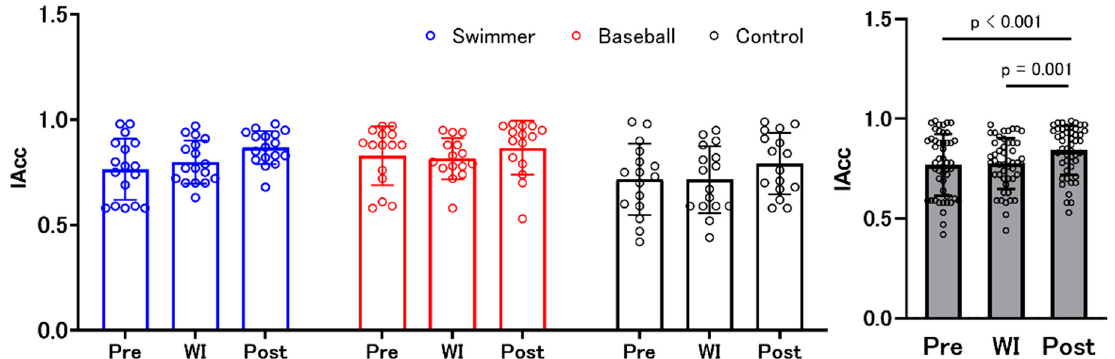
Figure 2. Changes in interoceptive accuracy (IAcc) scores in swimmers, baseball players, and control. Blue, red, and black bars indicate the swimmer, baseball, and control groups, respectively. There was no significant difference among the groups. Gray bars represent all participants with individual data (open circles). IAcc scores at post-water immersion (WI) were higher than those at pre-WI and during WI.